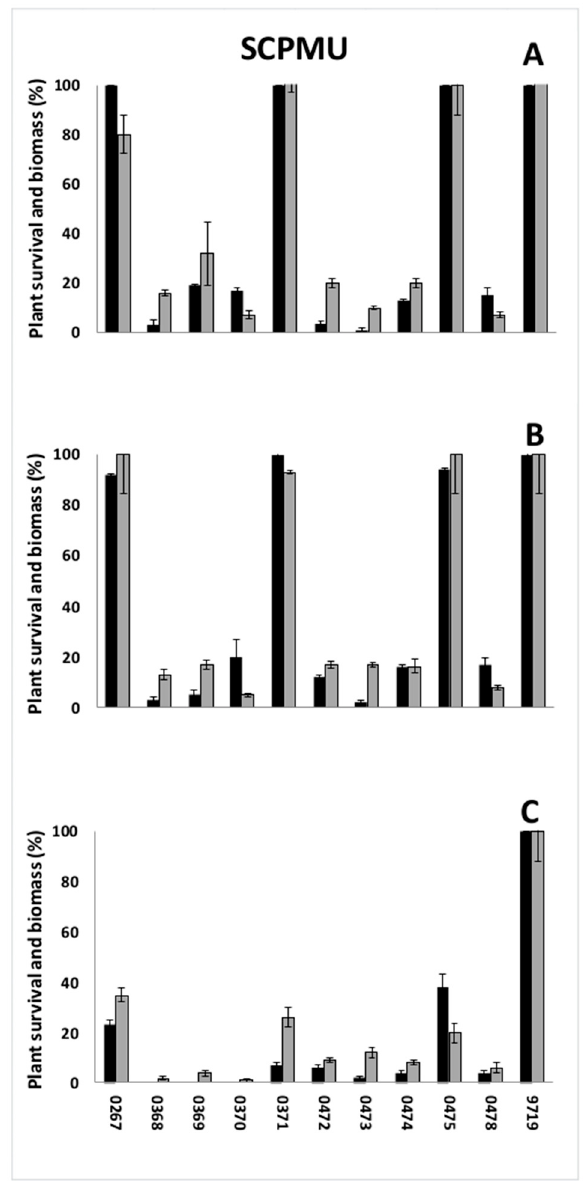
Figure 3. Sensitivity of populations of Schoenoplectus mucronatus (SCPMU) to three ALS inhibitors, azimsulfuron ( A ), bensulfuron-methyl ( B ), applied at full label dose corresponding to 20 and 60 g ai ha − 1 , respectively, and penoxsulam ( C ), applied at half the full label dose, corresponding to 20 g ai ha − 1 . Populations 9719 and 0267 are ALS-resistant checks. Values of survival (black bars) and biomass (grey bars) are expressed as percentage of the untreated control. Vertical bars represent standard errors.